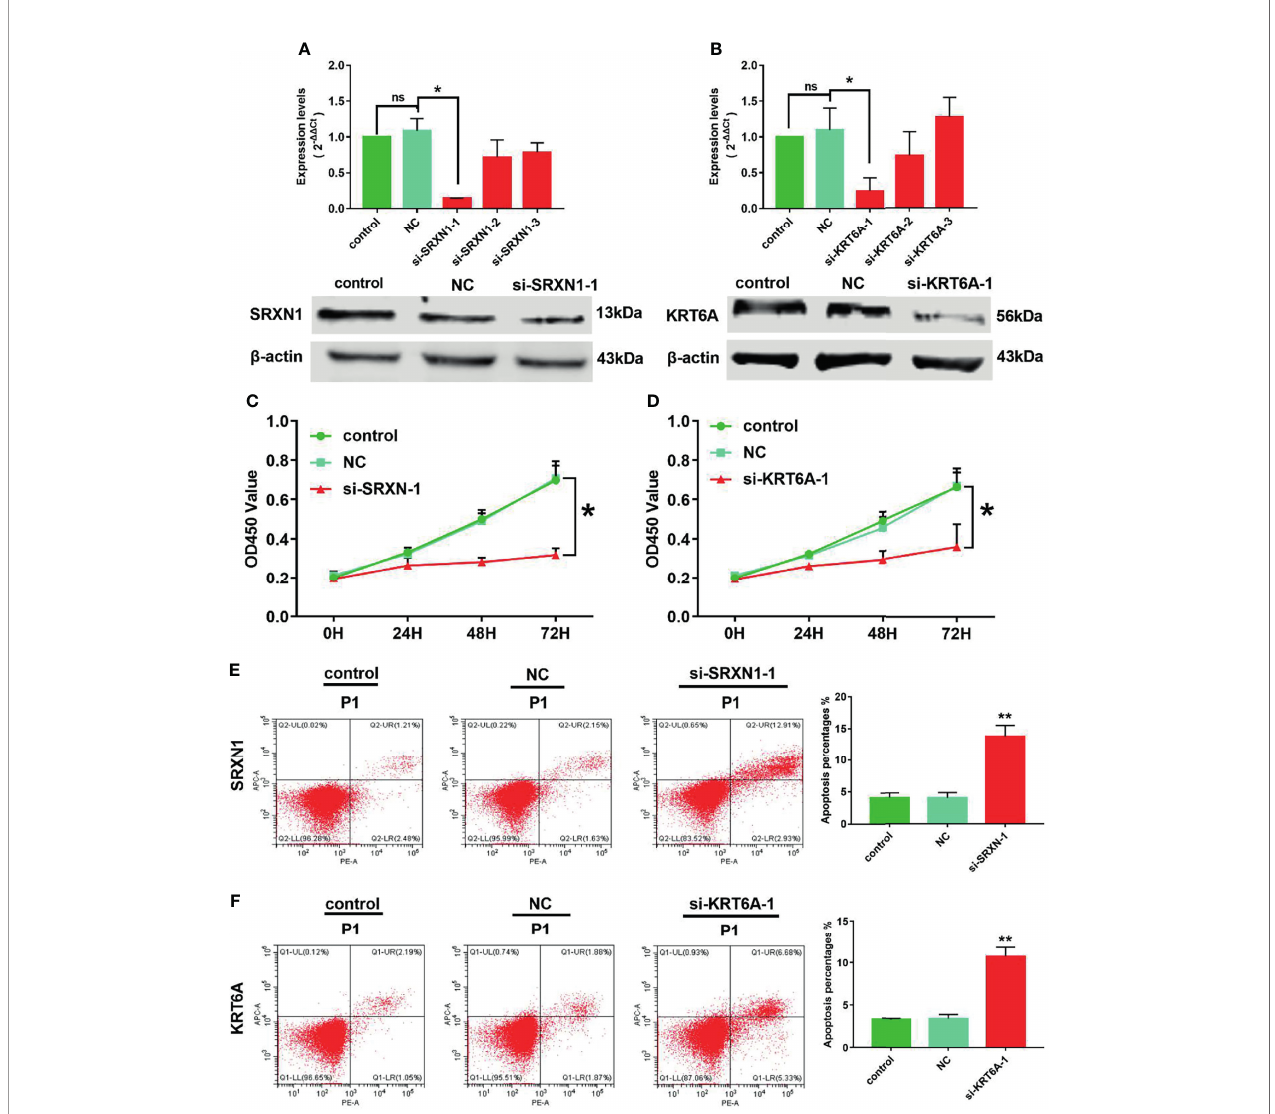
FIGURE 5 | SRXN1 or KRT6A inhibition suppressed cell viability and promoted cell apoptosis. (A) RT-qPCR and western blot analyses were performed to test the effect of SRXN1 interference. (B) RT-qPCR and western blot analyses were performed to test the effect of KRT6A interference. (C) Cell viability in response to SRXN1 depletion was monitored using a CCK-8 assay. (D) Cell viability in response to KRT6A depletion was monitored using a CCK-8 assay. (E) Representative fl ow cytometry plots of cell apoptosis in response to SRXN1 depletion and a graph of apoptosis rates per group. (F) Representative fl ow cytometry plots of cell apoptosis in response to KRT6A depletion and a graph of apoptosis rates per group. * P < 0.05, ** P < 0.01. NC, negative control; ns, no signi fi